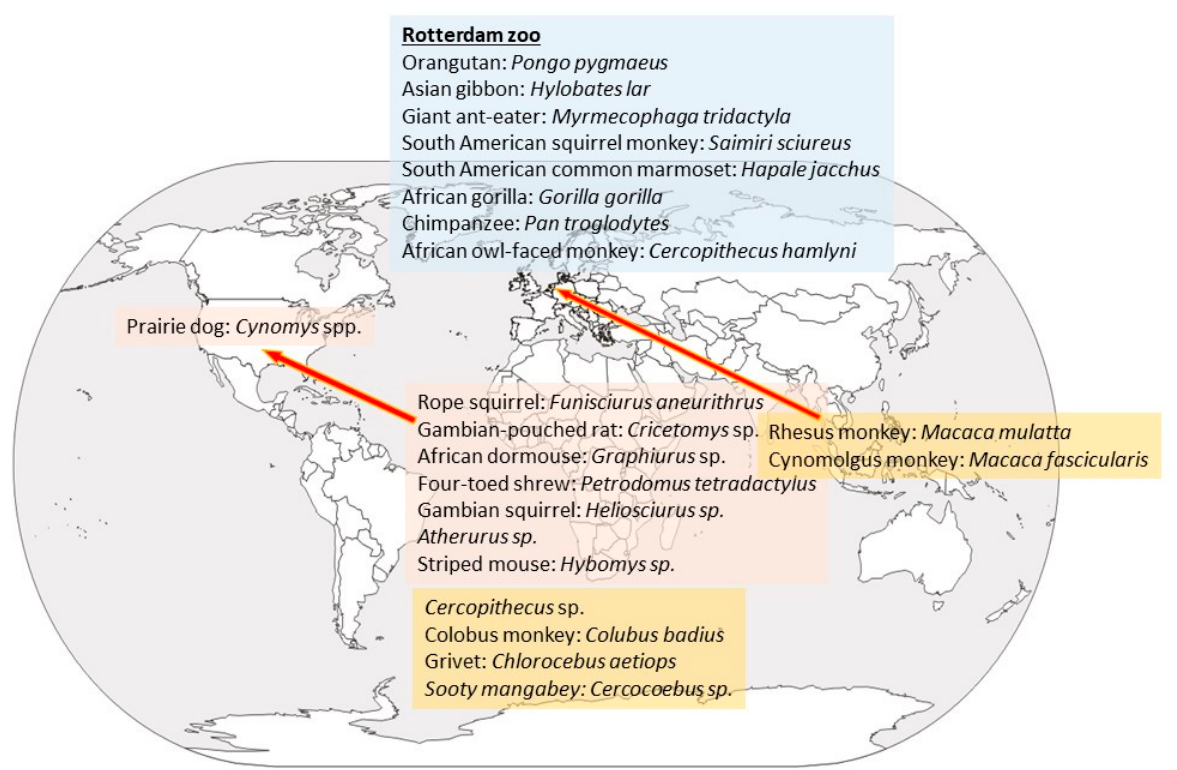
Figure 1. Species that have been found to be positive, either by virus isolation or presence of antibodies, and area of origin. Rodents are written in pink boxes; non-human primates in orange boxes and the species that were affected at the Rotterdam Zoo in a blue box.